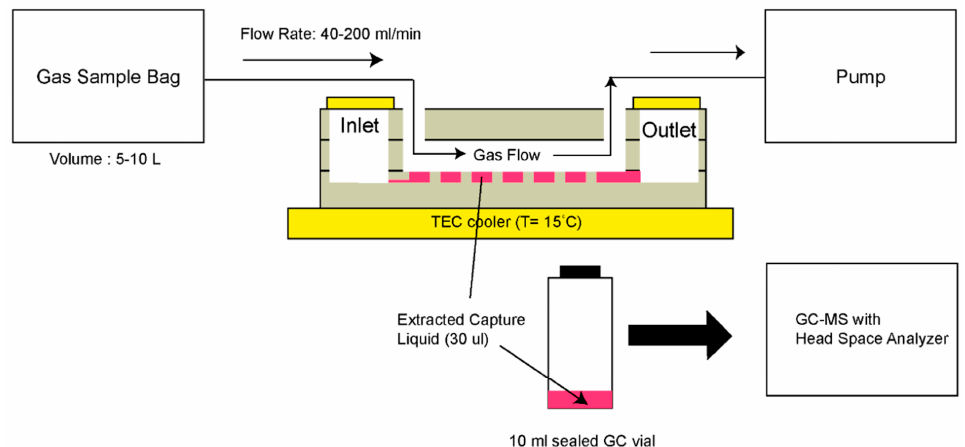
Figure 14. Schematic representing the gas sampling method. Reproduced with permission under the terms of the CC BY 4.0 license from [37] Copyright 2019, the authors, published by MDPI.